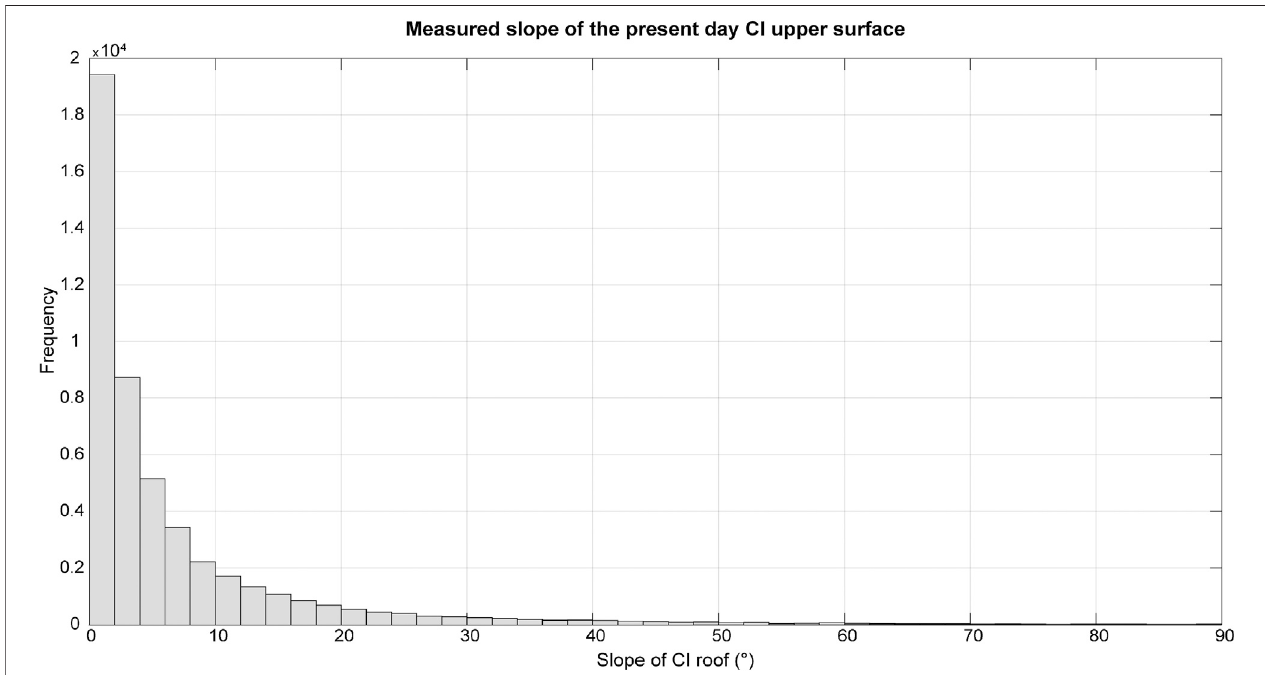
FIGURE 3 | Frequency of the slope of the upper surface of the Campanian Ignimbrite (CI). At least 80% of the exposed CI upper surface slopes less than 10 ° . The areas with slope greater than 35 ° are related to river incisions and CI escarpments.